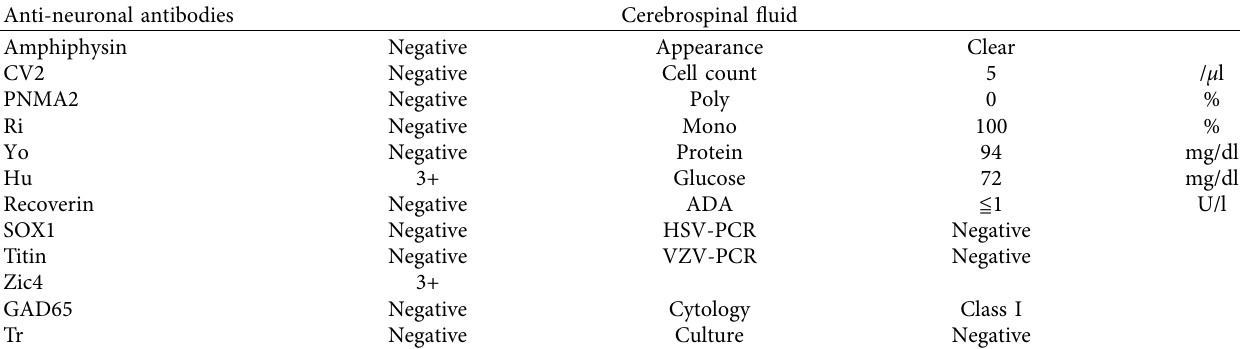
Table 1: Laboratory findings at the onset of PNS.